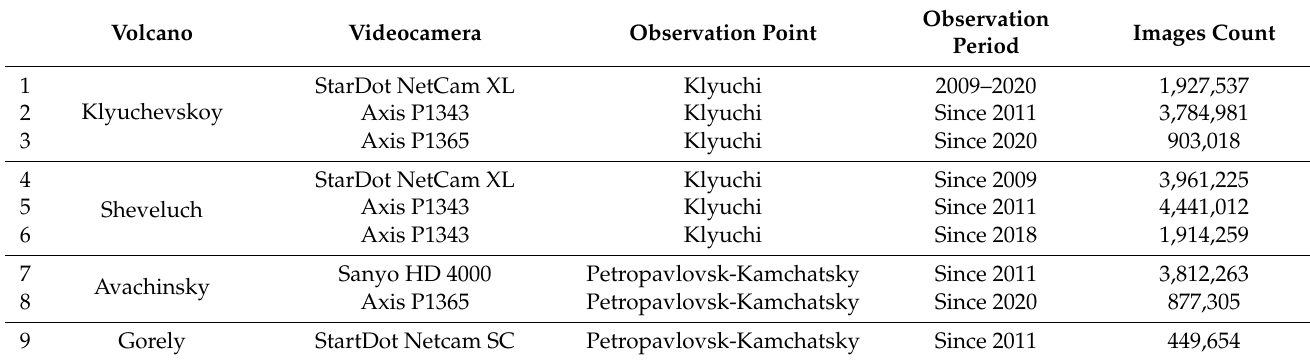
Table 1. The inventory and archive summary (as of the date of submission) of video observation system for Kamchatka volcanoes. Volcano Videocamera Observation Point